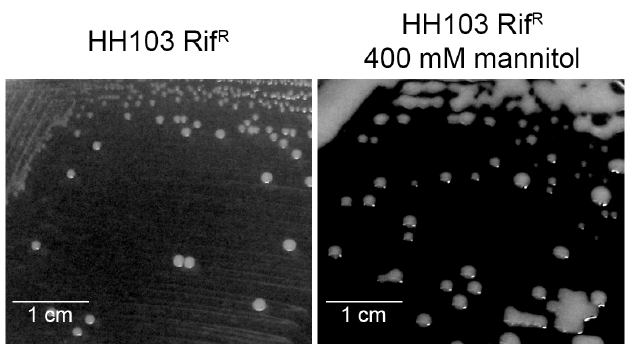
Figure 6. Mucoidy of S. fredii HH103 grown in TY medium in the absence or presence of 400 mM